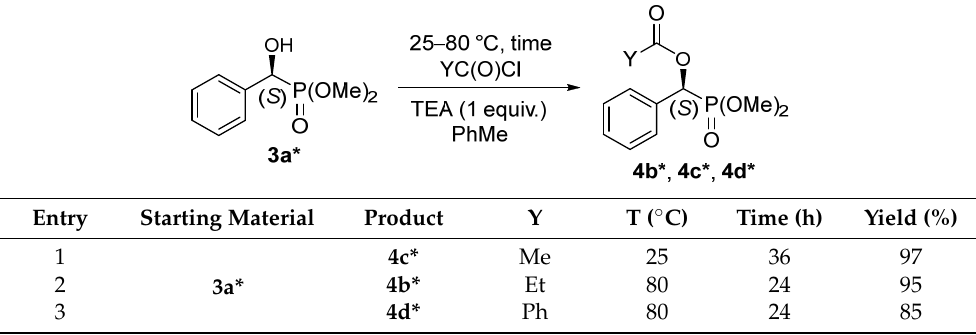
Molecules 2022 , 27 , x FOR PEER